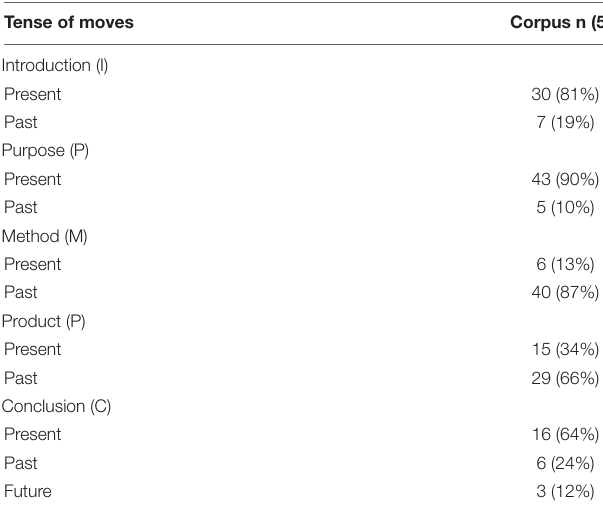
TABLE 3 | Verb tense frequency in each move in the